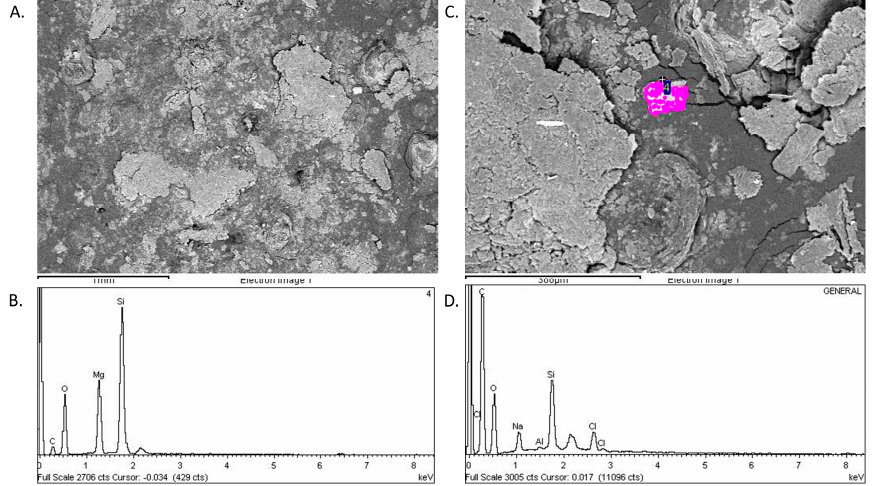
Figure 4. Electron microscopy images ultrafilter fibers from Dialysis center 2. ( A ) 1000 × magnification showing flake-like particles. ( B ) Elemental composition of the particles in ( A ). ( C ) 1500 × magnification of another particle and ( D ) Composition of the purple particle in ( C ). Particles in ( B – D ) have a higher signal for Si, O, Al, Na, and